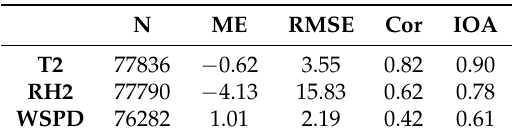
Table 3. WRF model performance for surface air temperature (T2), relative humidity (RH2) and wind speed (WSPD) for entire period and all SYNOP stations.